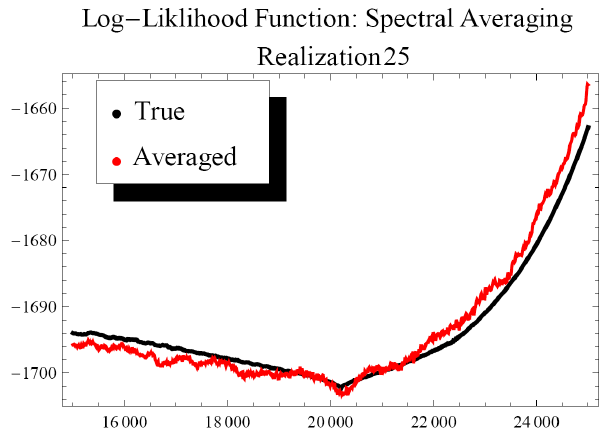
Fig. 22. SNR data for COSMIC occultation number 2 (black). Trend curve is in red and the vertical, dashed blue lines indicate the analysis